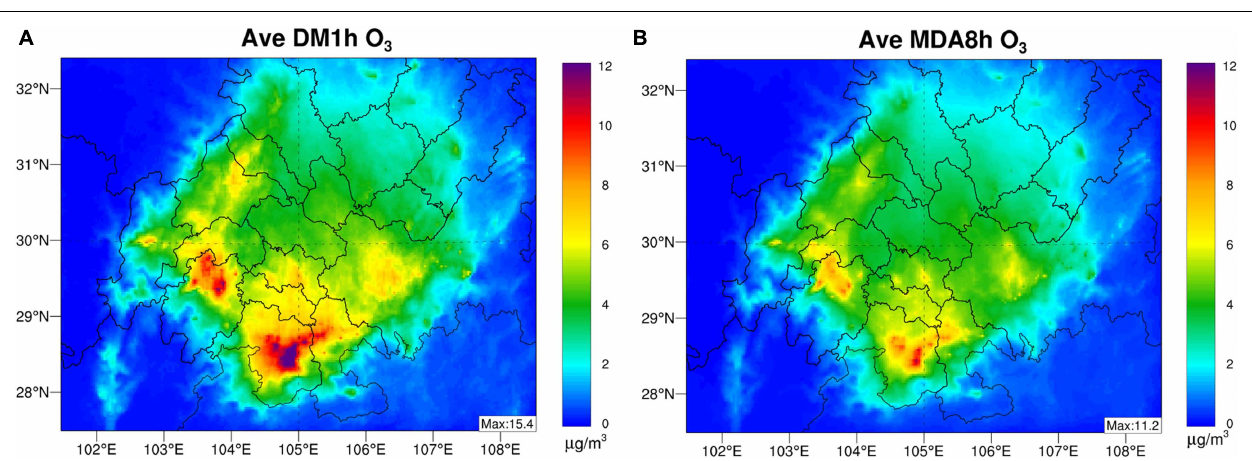
episodes with a far larger contribution than average values.